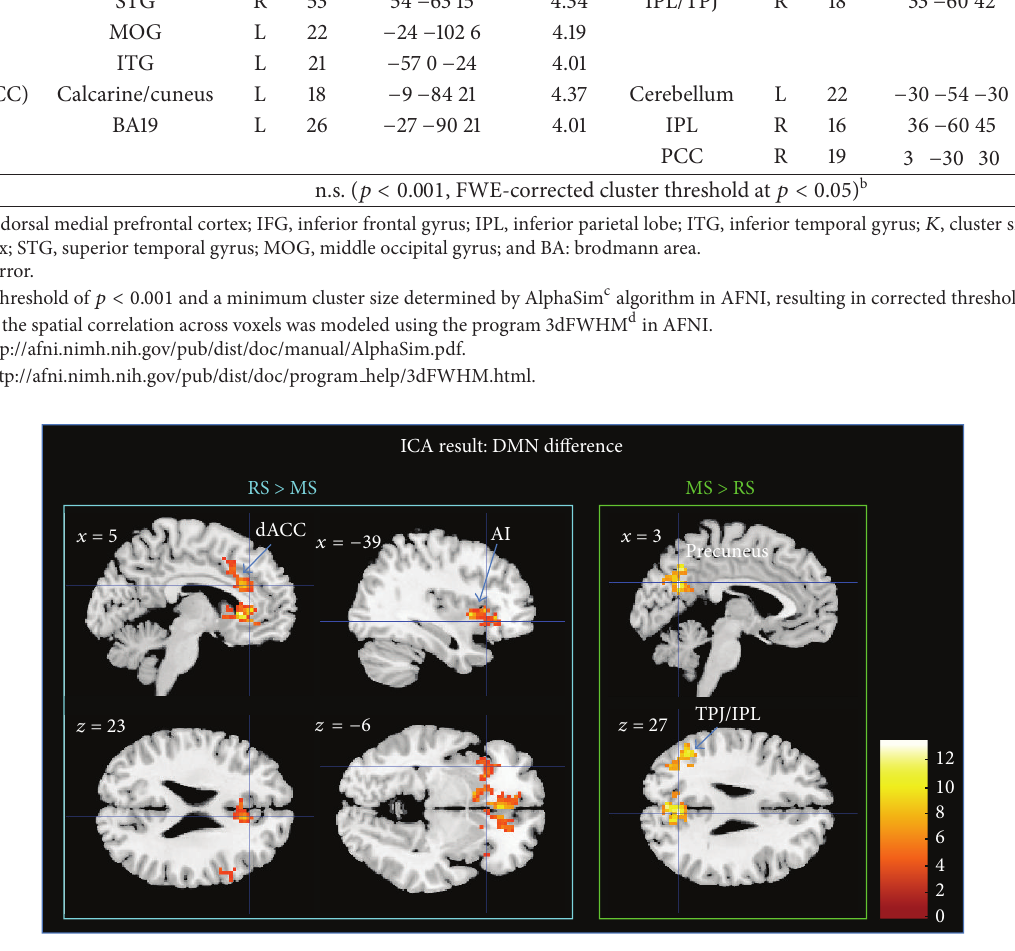
Figure 5: ICA results. DMN differences at TP2 for RS > MS and MS > RS ( 𝑝 < 0.05 , FWE-corrected). Bar plot represents the 𝑡 -values. White labels indicate the coordinate of each slice in the MNI frame of reference ( 𝑥,𝑧